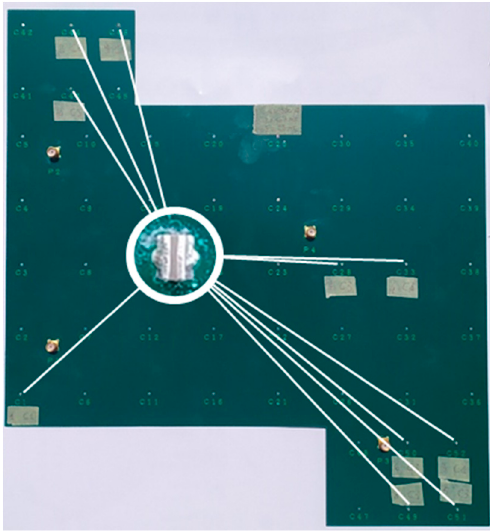
Figure 13. Assembled PCB and identification of the 10 decap locations.